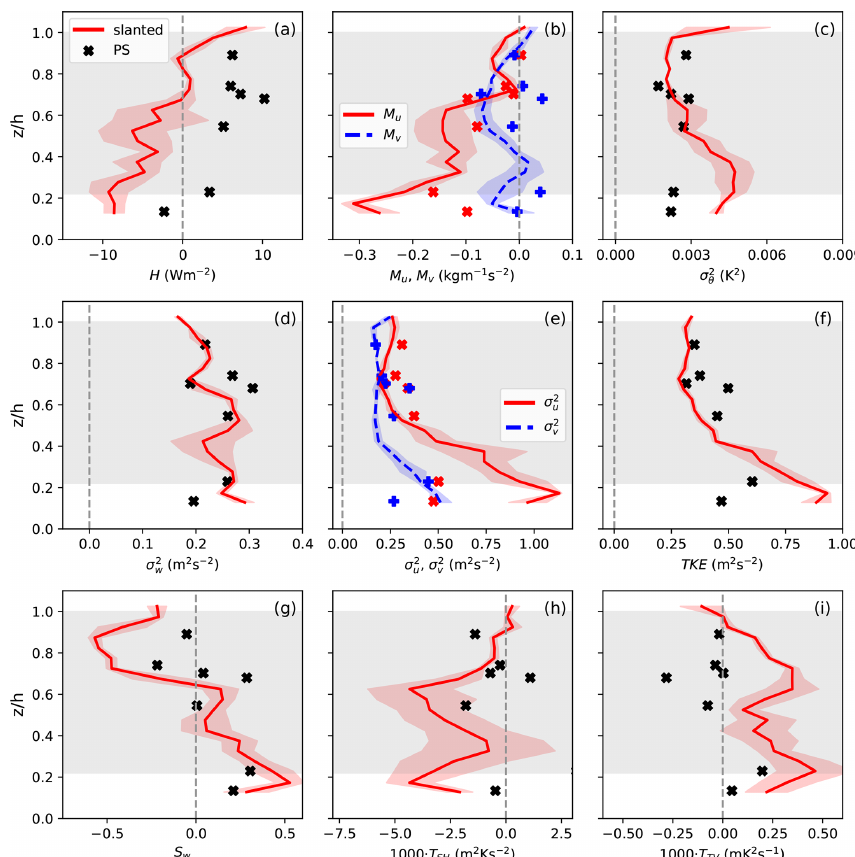
Figure 7. Vertical profiles of turbulence statistics obtained from horizontal legs over PS (black crosses) and slanted profiles T5 and T6 on 2 June 2017. Red lines represent mean values based on slanted profiles, while red shading indicates ± 1 standard deviation. The cloud layer as observed over PS is shown with grey